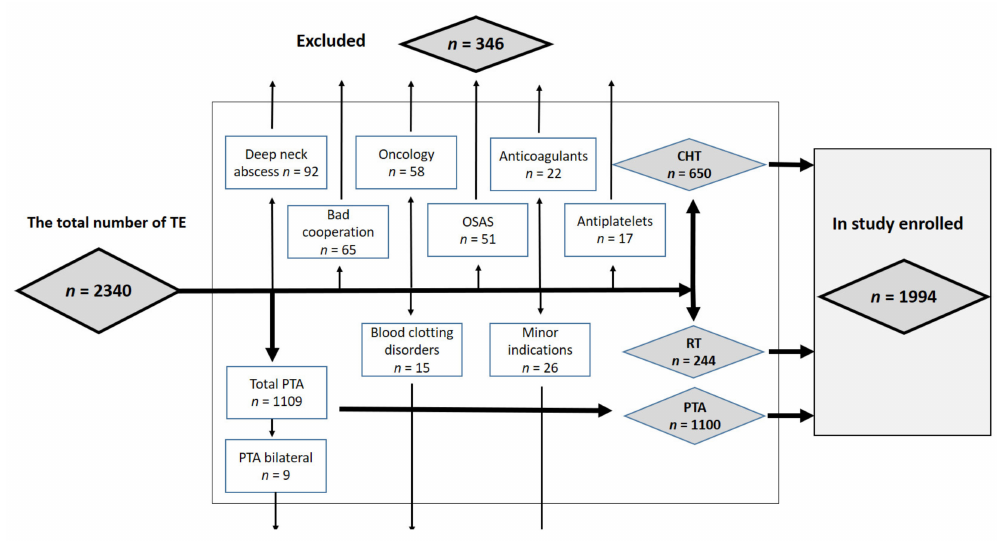
Figure 1. Flow chart—demonstration of an enroll/exclusion